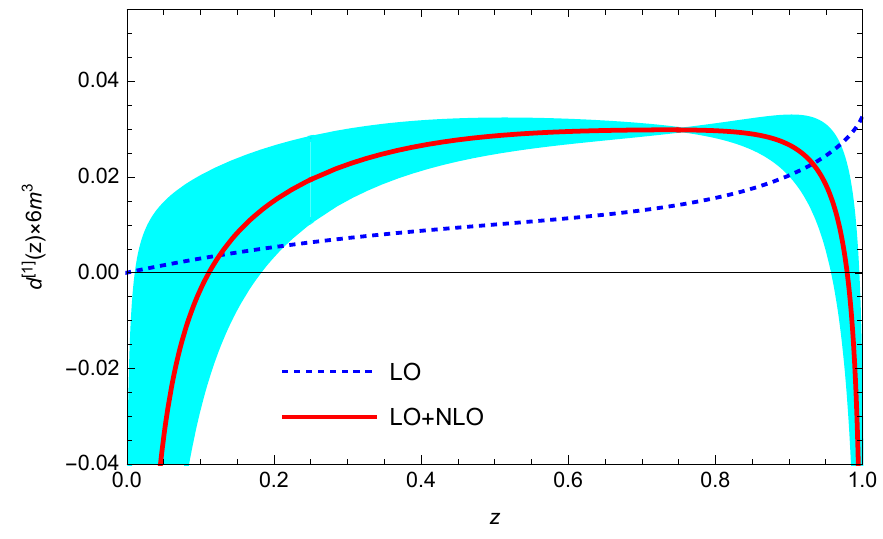
Figure 9 . SDCs of the fragmentation function of g ! b (cid:22) b ( 1 S [8] line is for d [8] ( z ) (cid:2) (96 m 3 = 5), while the solid line is for b LO choices (cid:22) r = (cid:22) f = 2 m b . The bands are obtained by varying the renormalization scale (cid:22) r by a factor of 2.